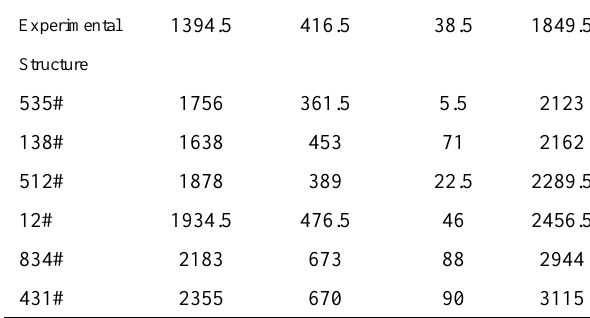
Table 10 Duration of abnormal conditions of Temperature in